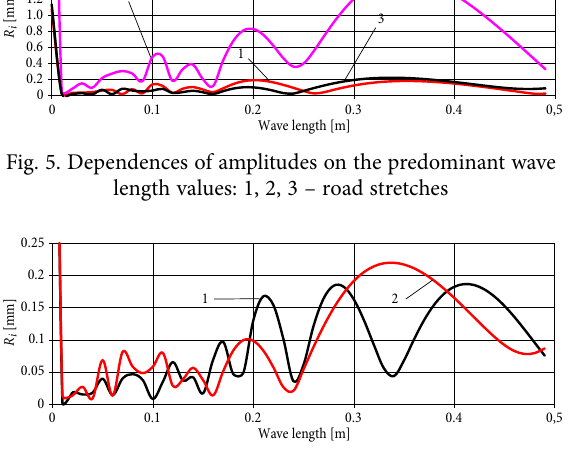
Fig. 6. Dependence of amplitudes on the predominant wave length values for the stretches of different length: 1 – 1 m; 2 – 0.5